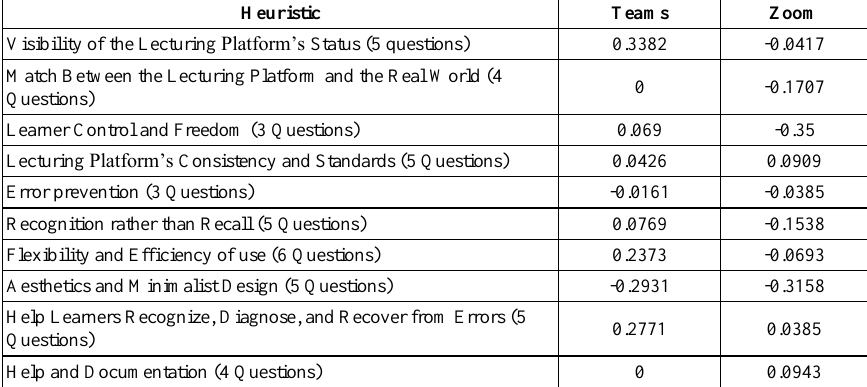
Table 7. Survey results for category 1 Heuristics (Interaction criteria) – numbers show Fleiss’s Kappa interrater agreement score among the three learners (auditory, visual and tactile) for each Heuristic Heuristic Teams Zoom